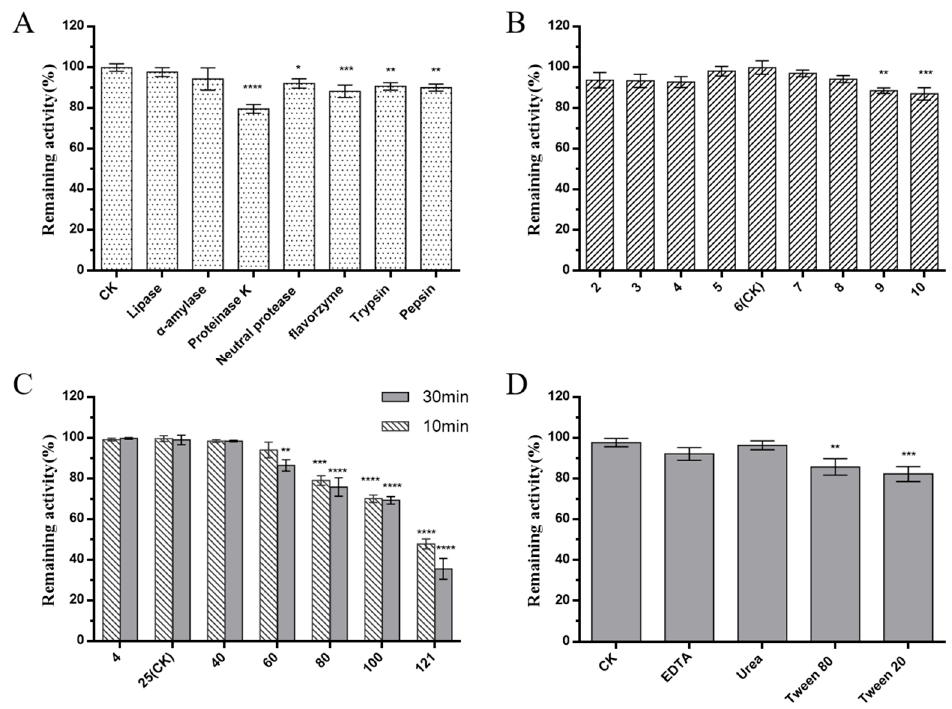
Figure 2. Stability of crude bacteriocins. ( A ) enzyme; ( B ) pH; ( C ) temperature; and ( D ) surfactant. The experiment was repeated three times. ( n = 3, * p < 0.05; ** p < 0.01; *** p < 0.001; **** p < 0.0001).